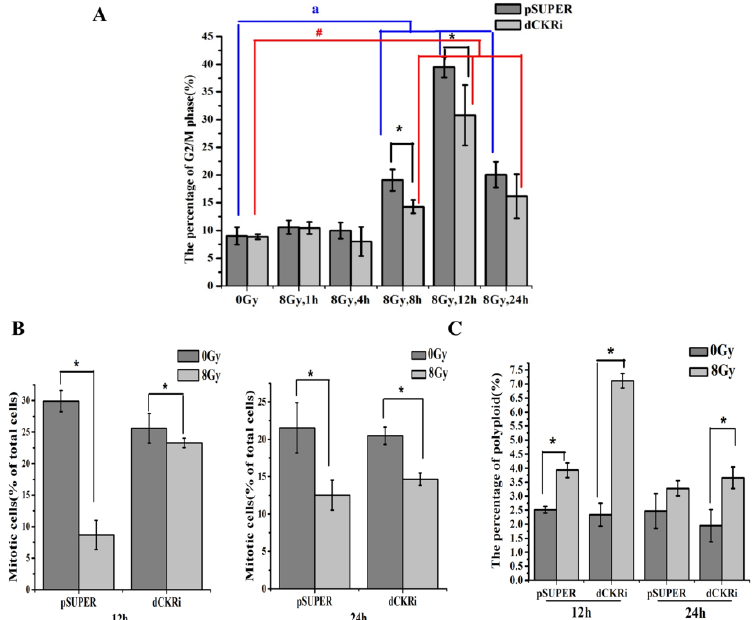
Figure 6. dCK inhibited IR-induced mitotic catastrophe. ( A ) Flow cytometry was used to quantitate the cell G2/M phase with or without IR at 1, 4, 8, 12, and 24 h in isogenic HeLa cells stably expressing control or dCK shRNA. All data are representative of three independent experiments and are shown as the mean ± SD. a p < 0.05 versus pSUPER cells treated with IR only, # p < 0.05 versus dCK knock-down cells treated with IR only. * p < 0.05 versus control group; blue lines are used to compare pSUPER cells treated with or without IR; red lineds are used to compare dCK knock-down cells treated with or without IR; ( B ) isogenic HeLa cell lines with control or dCK shRNA were treated with mock or IR treatment (8 Gy). 12 or 24 h later, cells were harvested and fixed followed by staining for Histone H3 Ser10 phosphorylation and analyzed by flow cytometry. The average and standard deviations of at least triplicate samples are shown. Statistic analysis was done by Student’s t -test; * p < 0.05 versus cells treated with IR only; ( C ) isogenic HeLa cell lines with control or dCK shRNA were treated with or without IR (8 Gy). After 12 or 24 h, cells were stained by DAPI and detected by flow cytometry. * p < 0.05 versus cells treated with IR